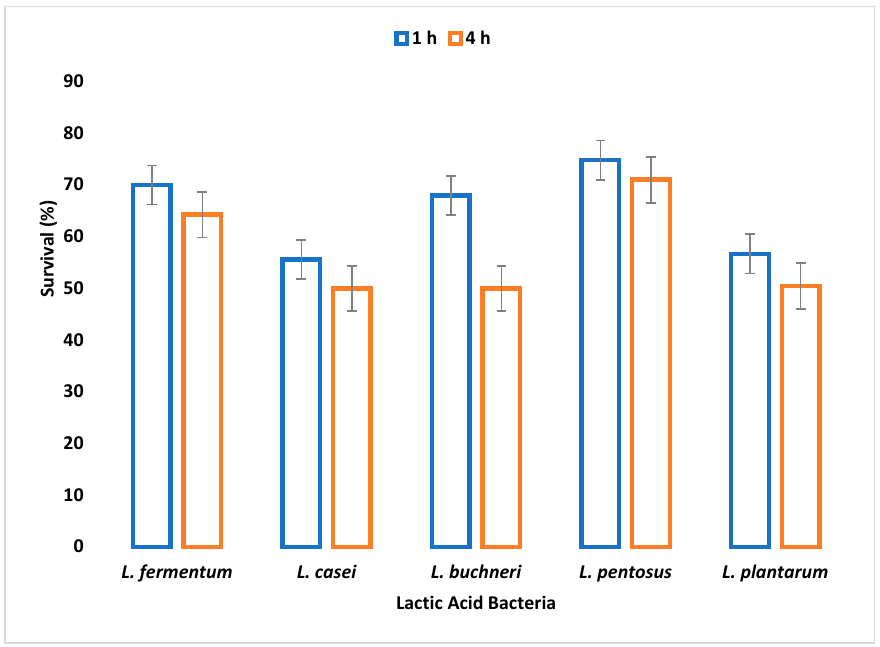
Figure 6. Survival of lactic acid bacteria isolates in 1% bile salt after 1 and 4 h, respectively. L. fermentum isolates were well suited to adapt and survive in 1% bile salt. All LAB isolates tolerated simulated gastric juice at pH 2.5 after 4 h of incubation, with survival rates ranging between 64–90%. L. casei had the lowest survival rate at 64%, and L. fermentum had the highest survival rate at 90% (Figure 7).